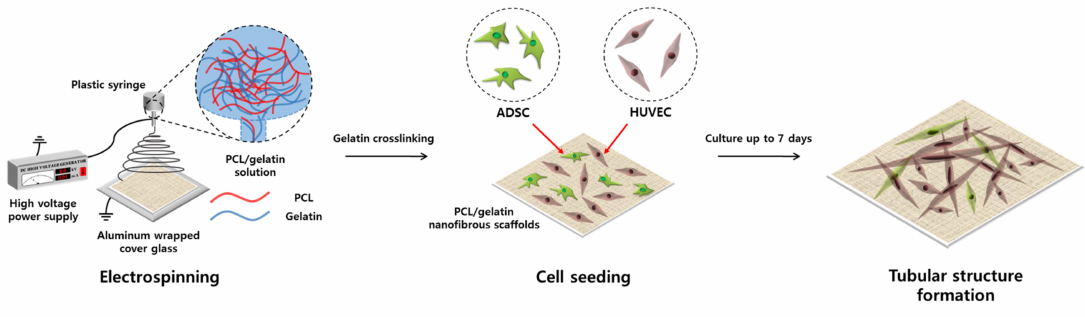
Figure 1. Schematic illustration of the PCL/gelatin nanofiber scaffolds using electrospinning process and co-culture system of ADSCs and HUVECs for blood vessel formation of the scaffolds.